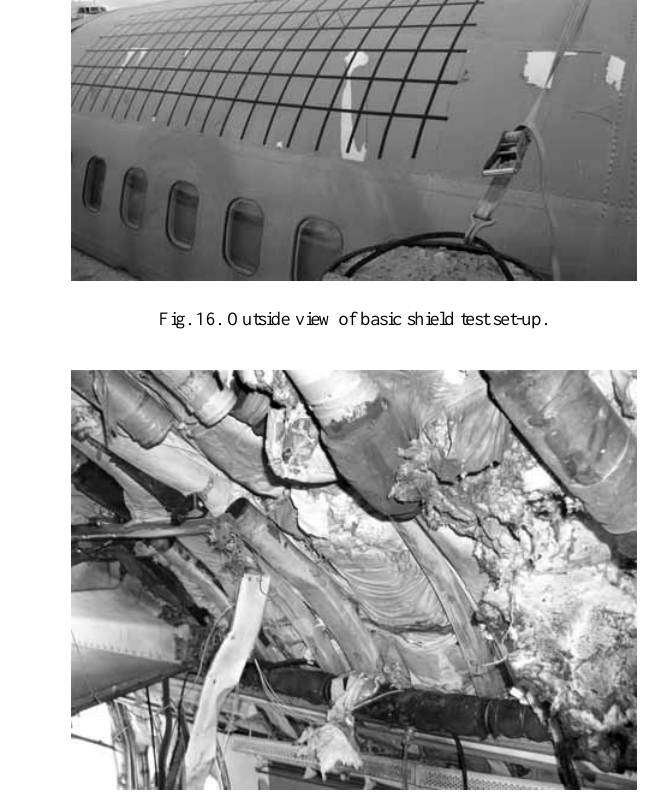
Fig. 17. Inside view of fuselage after basic shield